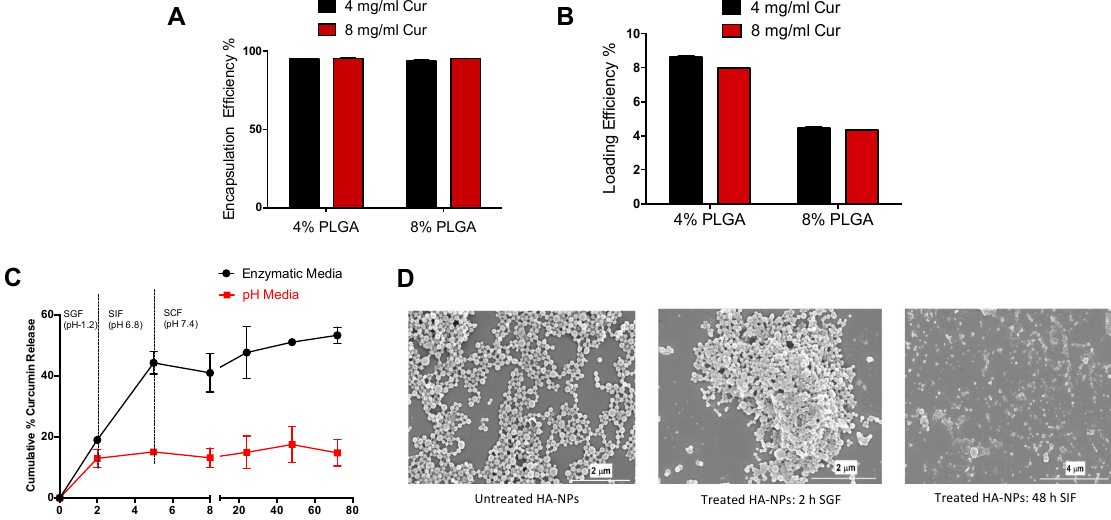
Figure 3. Curcumin encapsulation, loading efficiencies and drug release studies in simulated gastrointestinal fluids. Encapsulation and loading efficiencies of different polymer to drug ratios ( A , B ). In vitro curcumin release profile in pH and simulated gastric, intestinal fluids ( C ). Scanning electron microscopy images of in vitro particle degradation of untreated, 2h simulated gastric fluid treated, 48h simulated intestinal fluid treated NPs ( D ).